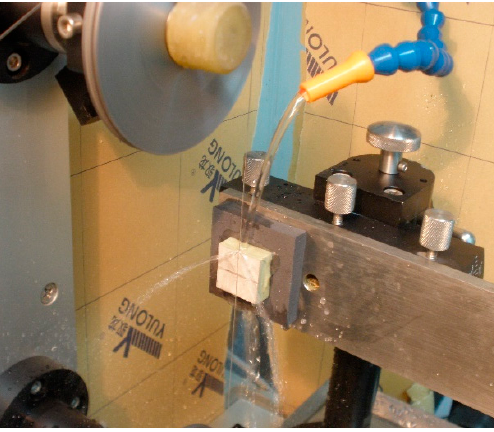
Figure 1. Wire electrical discharge machine.